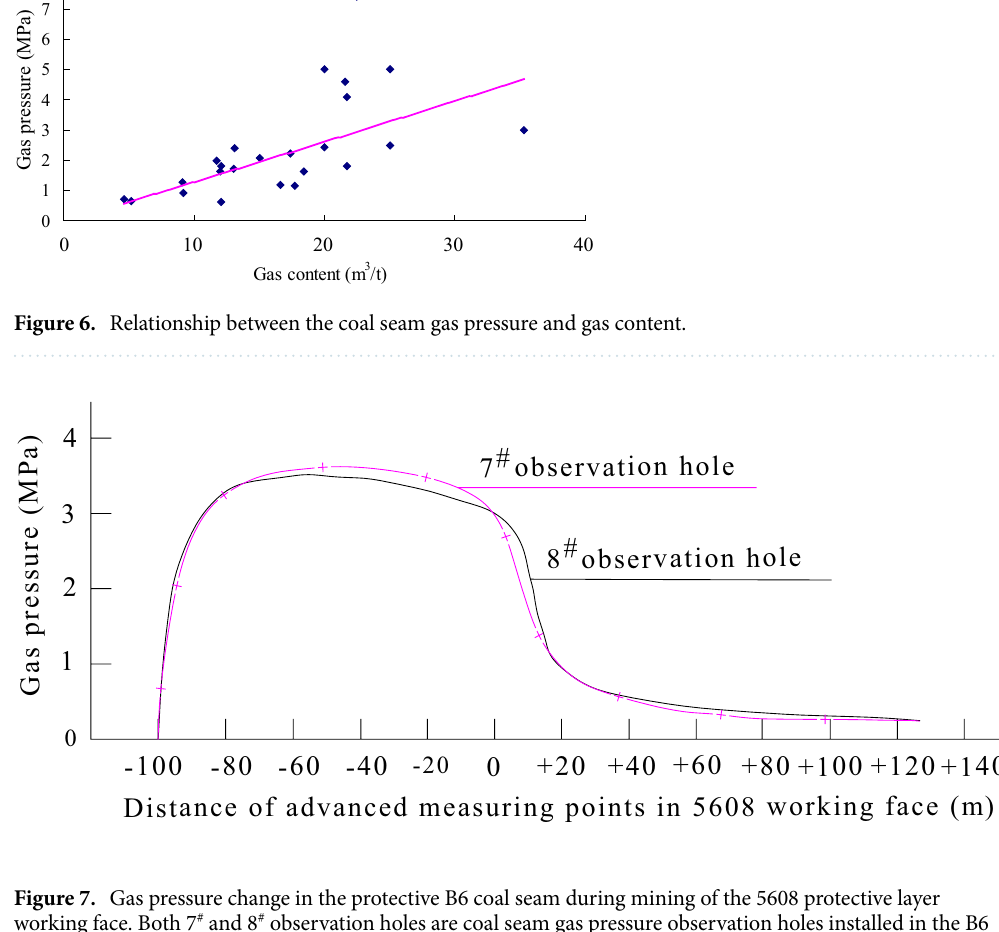
Figure 7. Gas pressure change in the protective B6 coal seam during mining of the 5608 protective layer working face. Both 7 # and 8 # observation holes are coal seam gas pressure observation holes installed in the B6 protected coal seam during the mining of the 5608 protective layer working